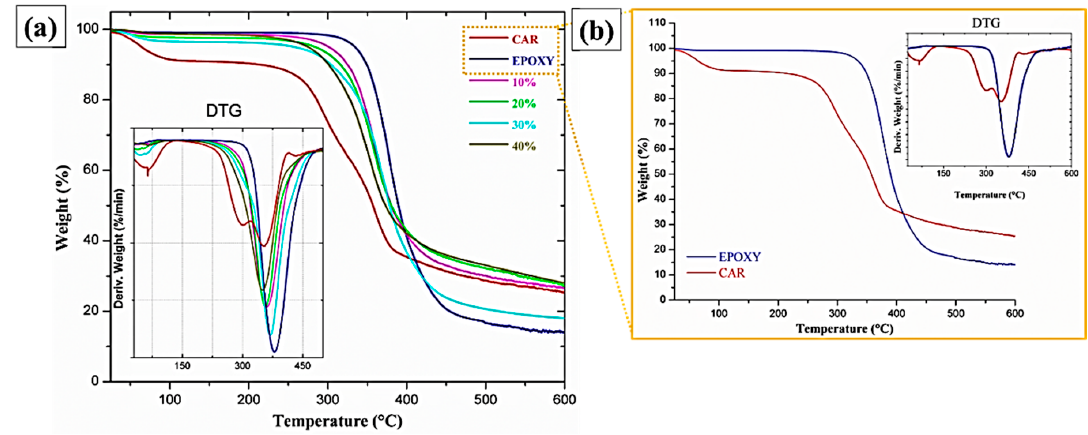
Figure 13. Thermogravimetric curves for carnauba fibers, resin, epoxy, and composites ( a ); carnauba fibers and epoxy resin ( b ).